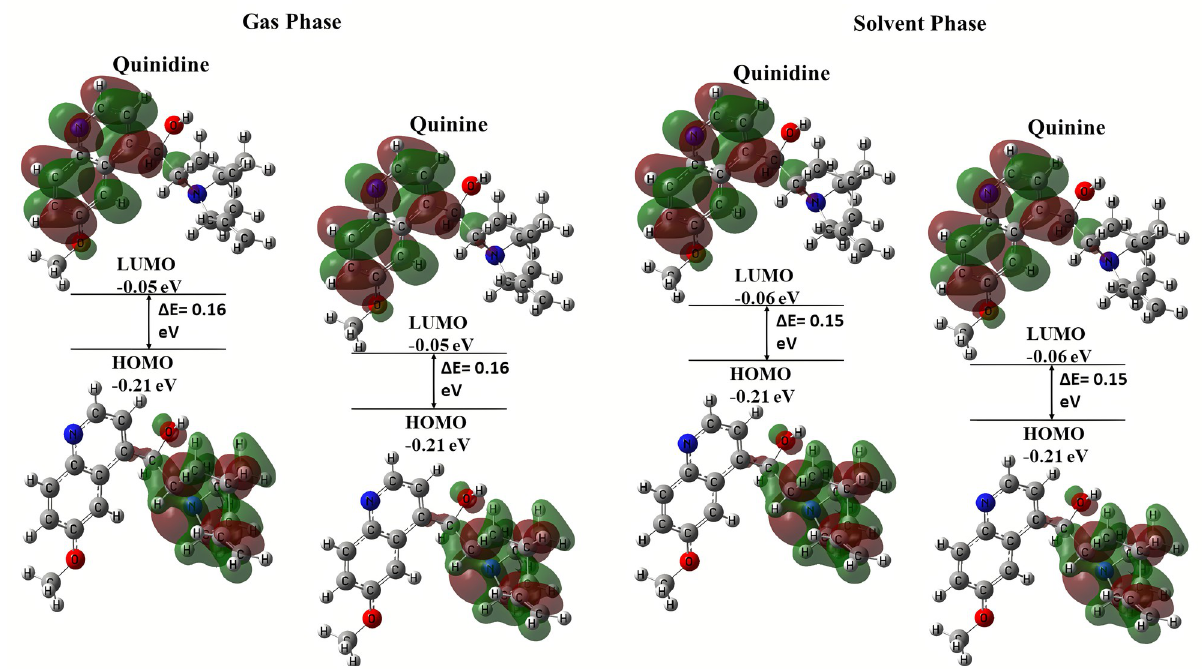
Fig 2. HOMO and LUMO structures of quinolone derivatives in gas and solvent (water) phase.